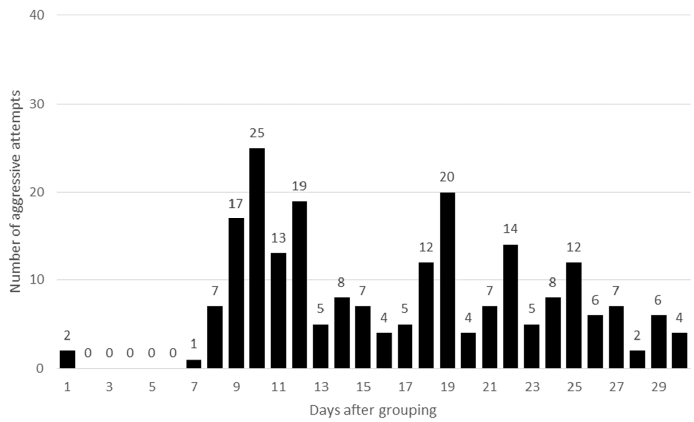
Figure 1. Cumulative number of aggressive behaviours in homogenous (HOM) groups.